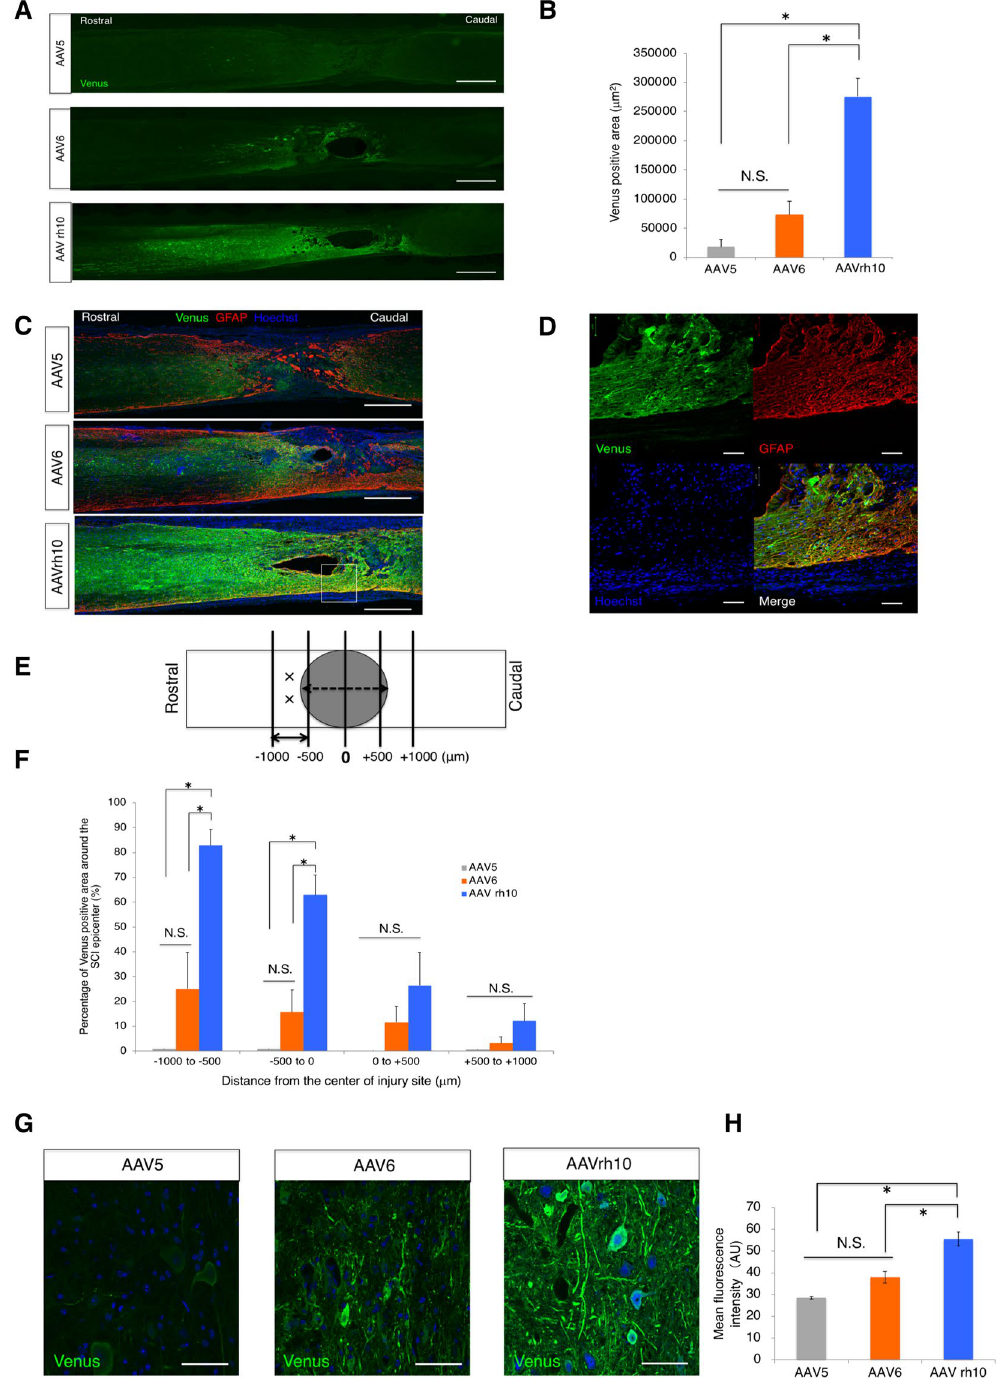
Figure 5. Characteristics of transgene expression in the injured spinal cord during the chronic phase. Sections were immunostained with an anti-GFP antibody. ( A ) Representative immunostained images of the spinal cord after 6 weeks of AAV- ff Luc injection. Scale bars, 500 μ m. ( B ) Quantification of the transduced area of AAV- ff Luc in the chronically injured spinal cord. ( C ) Representative images of the differences in transduction around the injury epicentre, which was immunostained with GFAP to outline the lesion area. Note that the vector was injected only rostrally to the epicentre. Scale bars, 500 μ m. ( D ) Higher magnification of the area in the square. Colocalization of Venus and GFAP was observed. Scale bars, 50 μ m. ( E ) Schematic representation of the quantification, with a focus on transduction around the injured region. The grey area represents the diameter of the IH impactor tip (1250 μ m). X points represent injection sites. Zero points indicate the centre of the diameter tip. We set the rostral side as negative and the caudal side as positive. Quantification was performed every 500 μ m from the rostral and caudal sides. ( F ) Quantification of the percentage of Venus-positive area/spinal cord area in the 500 μ m width around the SCI epicentre. ( G ) Representative images of ff Luc-driven